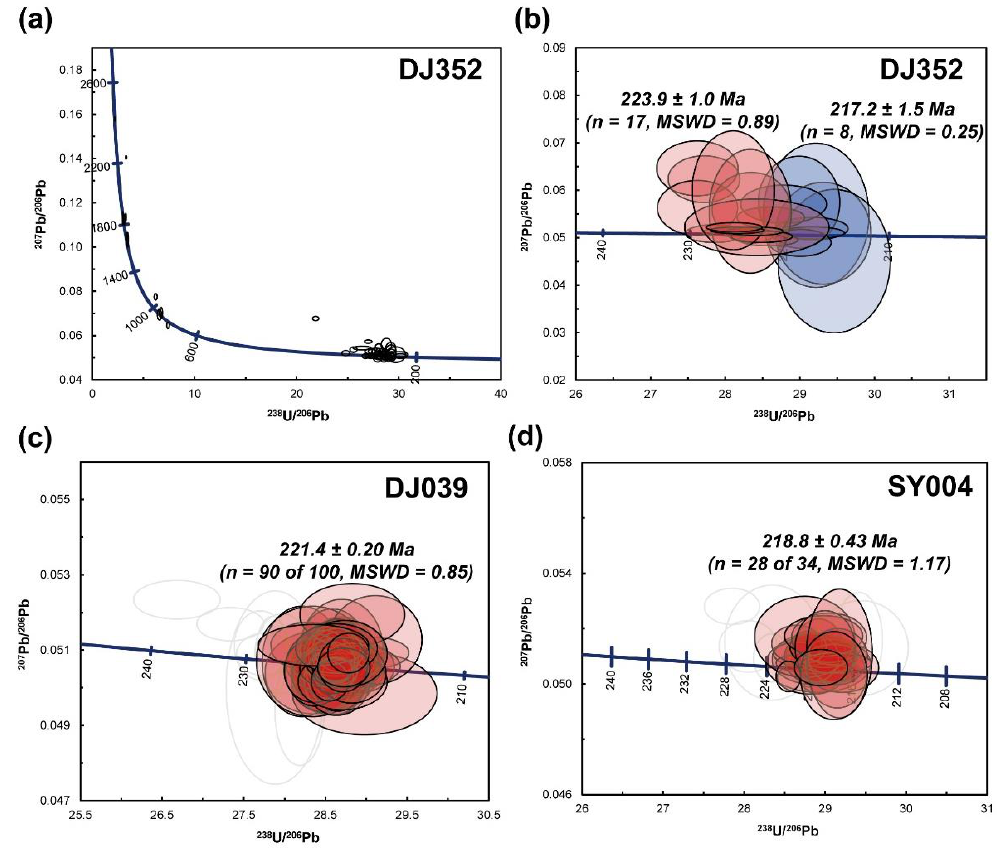
Figure 10. Concordia plots of zircon SHRIMP and LA-MC-ICP-MS U-Pb isotopic data from the deformed felsic tuff ( a ), ( b ), deformed quartz porphyry ( c ), and mylonitized porphyritic granite ( d ).